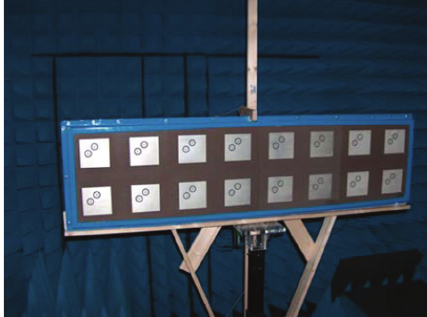
Figure 7: Measured radiation pattern of SAR-Low antenna: copolar and cross polar components @ 450MHz.